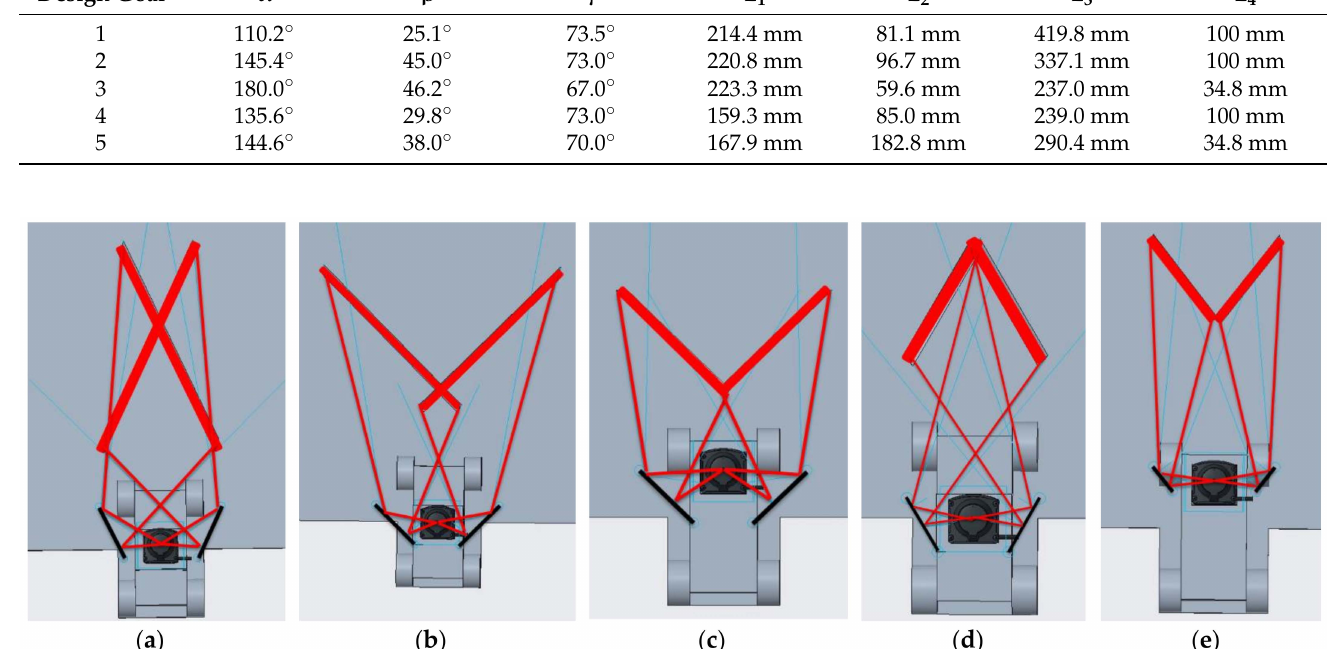
Figure 7. Top views of typical resulting CADs for the five design goals 1 to 5. The displayed geometries in ( a – e ) correspond to the listed geometry parameters 1 to 5 in Table 3. The thick red lines show where the Lidar laser scans the ground in front of the vehicle, and the thin red lines show the laser beam path from the Lidar center towards both ends of the thick red lines on the